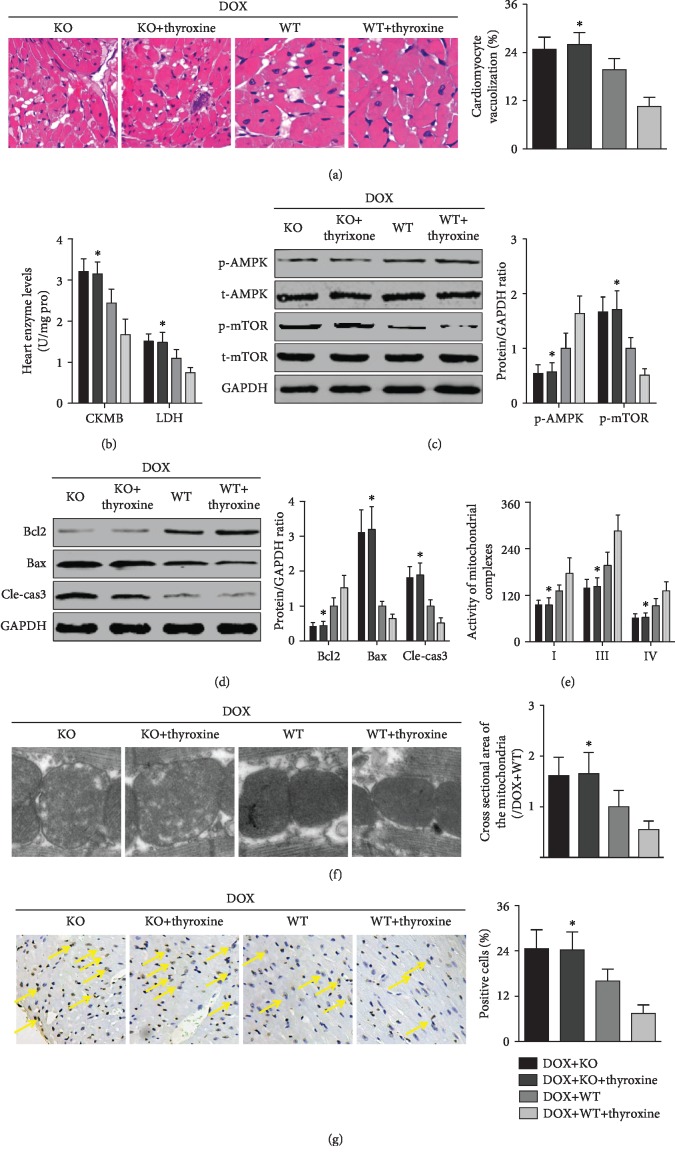
Effect of LKB1 KO on cardiac injury, energy failure, and myocardial cell apoptosis. (a) Heart sections were stained with HE, and the numbers of vacuolated cardiomyocytes in the four groups were quantified (200x). (b) Heart LDH and CK-MB levels were detected for each group. (c) Representative images and quantification of AMPK/mTOR axis phosphorylation. (d) Bcl2, Bax, and cleaved caspase-3 expression in the LV of each group. (e) Mitochondrial complex I, III, and IV activation was detected. (f) The cross-sectional area of the mitochondria in each group and more than 50 mitochondria were measured (5000x). (g) Representative images of TUNEL staining and the quantitative results for each group (200x); arrows indicate TUNEL-positive cells. N = 6 in each group. ∗P < 0.05 vs. DOX+thyroxine group.